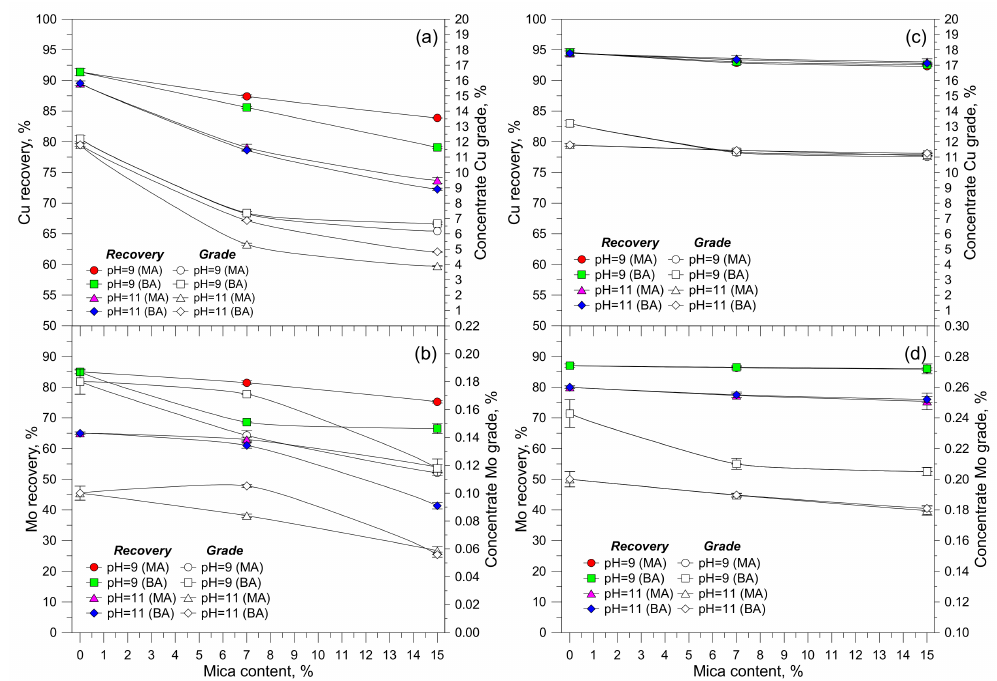
Figure 1. Recoveries and concentrate grades of copper and molybdenum as a function of mica content at pH 9 and 11 in seawater ( a , b ), and in a 0.01M NaCl solution ( c , d ). MA and BA stand for muscovite and biotite additions,